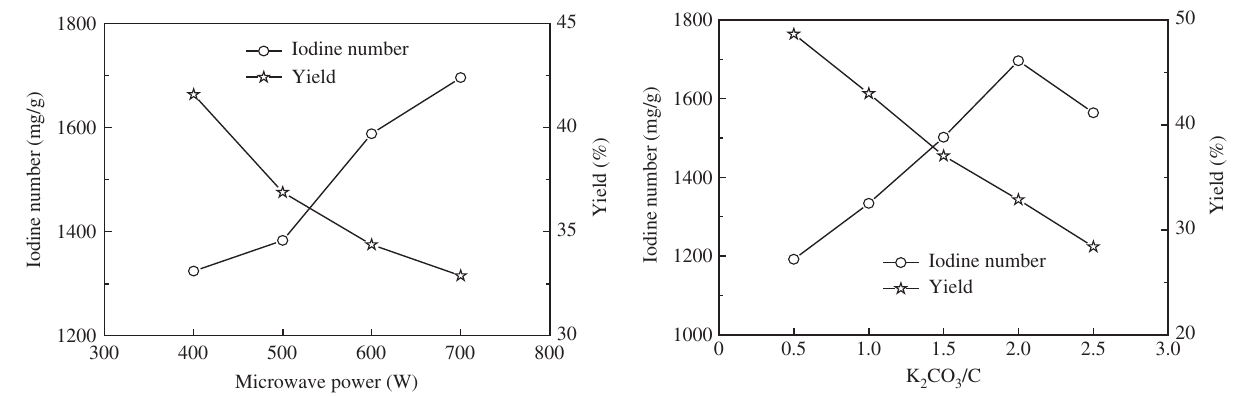
CO ratio on iodine number and yield of high Figure 3: Effect of K 2 3 surface area activated carbon